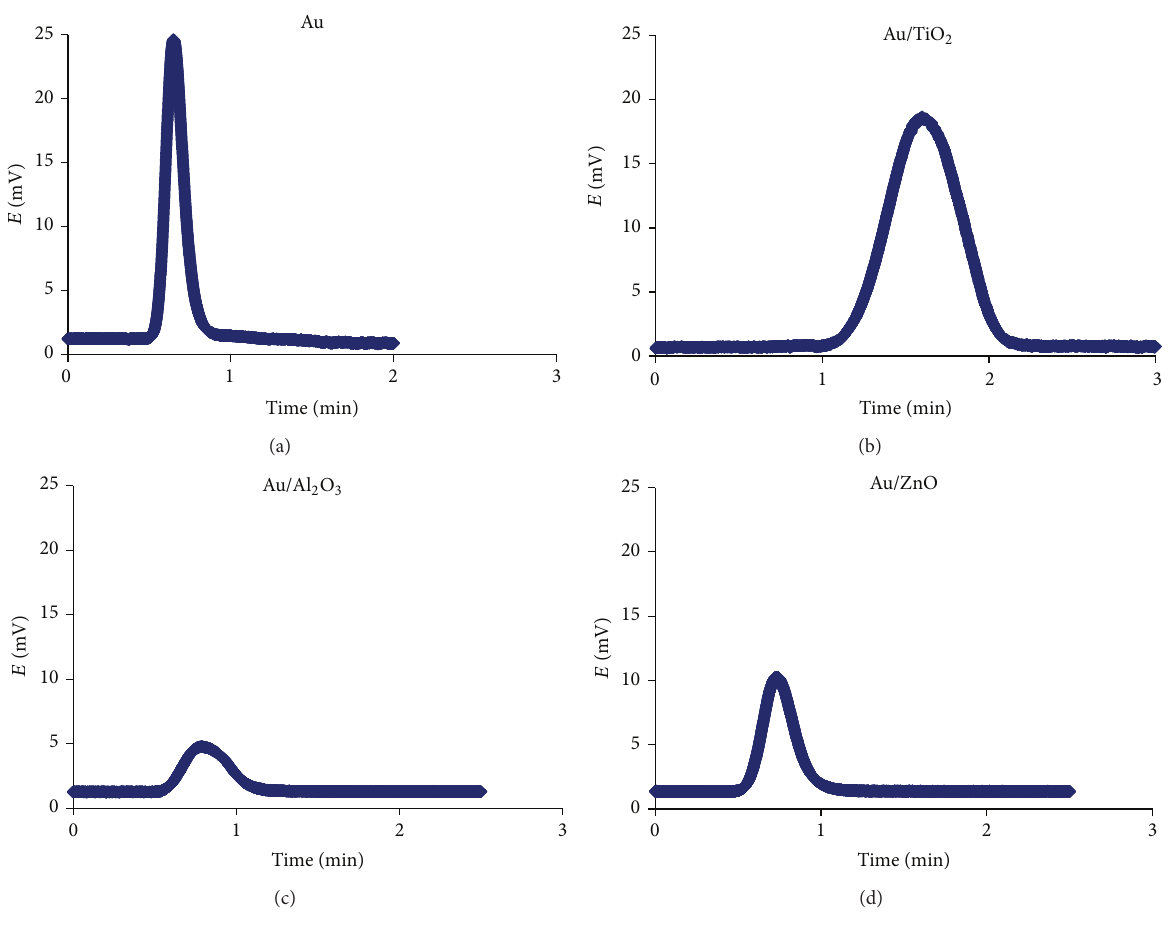
Figure 4: AFS chromatograms of 10 𝜇 L Hg 0 desorbed from different traps.